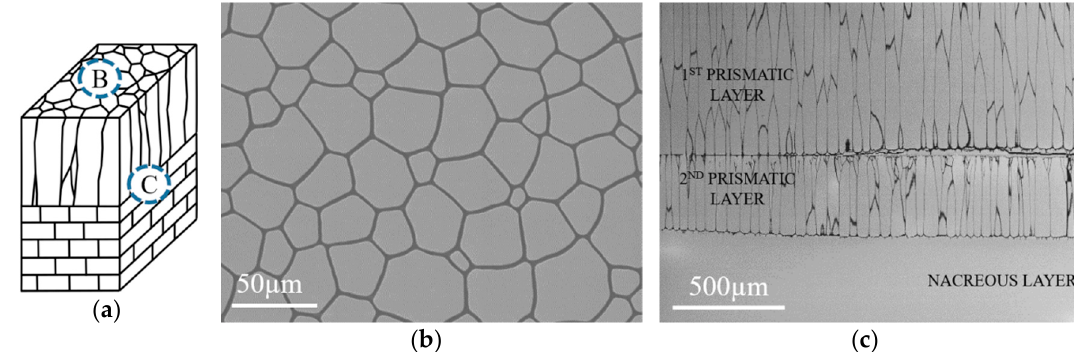
Figure 3. Schematic cross-section of P. margaritifera mollusk shell with marked areas of SEM observations ( a ) and corresponding SEM/BSE microstructure images acquired from the section perpendicular to ND ( b ) and LD ( c ).